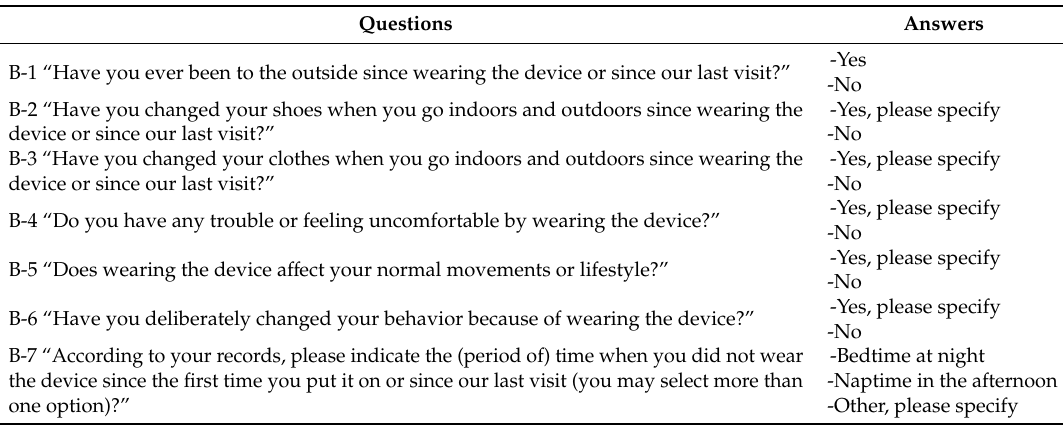
Table A2. Summary of questions in the “personal thermal exposure experience” survey.